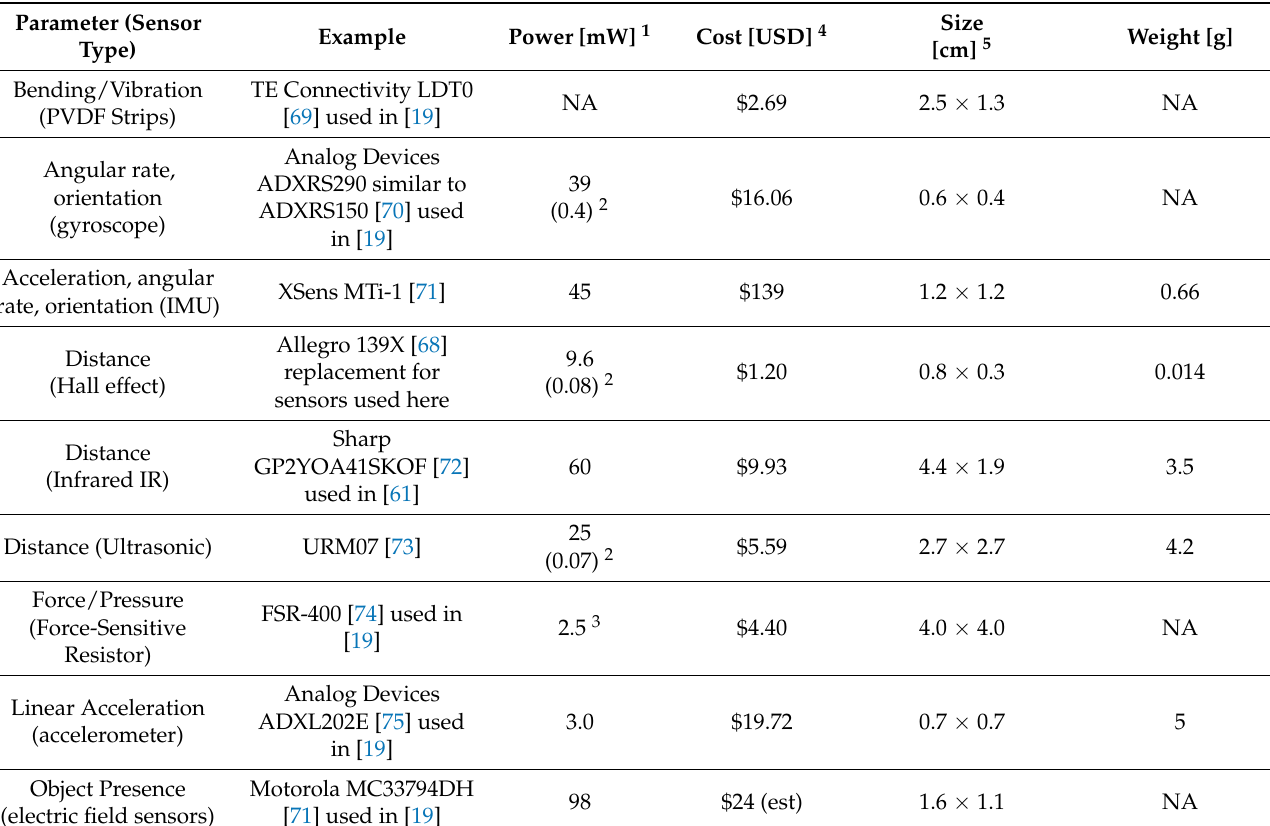
Table 13. Typical Constraints of Sensors Used in Wearable Gait